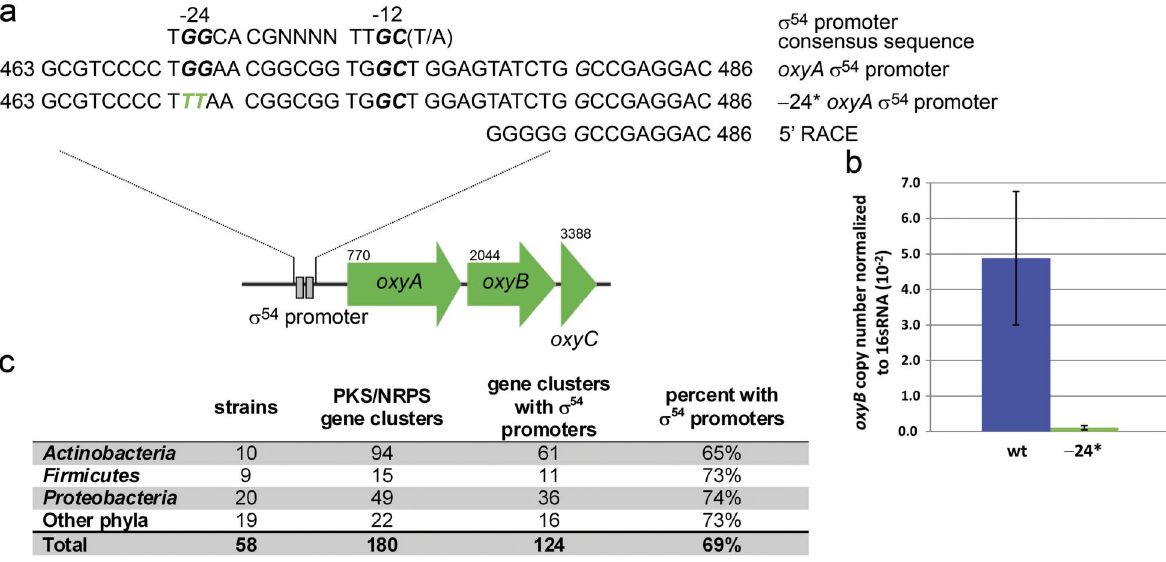
Figure 3. Putative s 54 promoters are found in the majority of polyketide and non-ribosomal peptide biosynthetic gene clusters. ( a ) The oxyABCDEF operon from the S. rimosus oxytetracycline biosynthetic pathways contains a putative s 54 promoter. The promoter shows high homology to the s 54 promoter consensus sequence especially at the key 2 12 and 2 24 positions. A mutation of the highly conserved GG residues at 2 24 ( 2 24*) and 5 9 RACE were used to confirm that this promoter is responsible for direct, positive transcriptional regulation of the oxyB gene by s 54 over-expression. ( b ) Transcription of the oxyABCDEF operon is directly controlled by the s 54 promoter upstream of oxyA . Mutation of the highly conserved GG residues 2 24 from the transcriptional start site to TT leads to a greater than 40 fold decrease in oxyB transcript levels as determined by qPCR. qPCR data was obtained from BAP1 transformed with pDCS11 and either pDCS61 or pDCS62. ( c ) Results of a bioinformatics analysis of 58 bacterial genomes containing 180 polyketide synthase (PKS) and non-ribosomal peptide synthetase (NRPS) biosynthetic gene clusters show that the majority of gene clusters contain putative s 54 promoters. It is particularly intriguing that Actinobacteria possess gene clusters with s 54 promoters since they lack the gene encoding s 54 . See also Tables S2, S3,